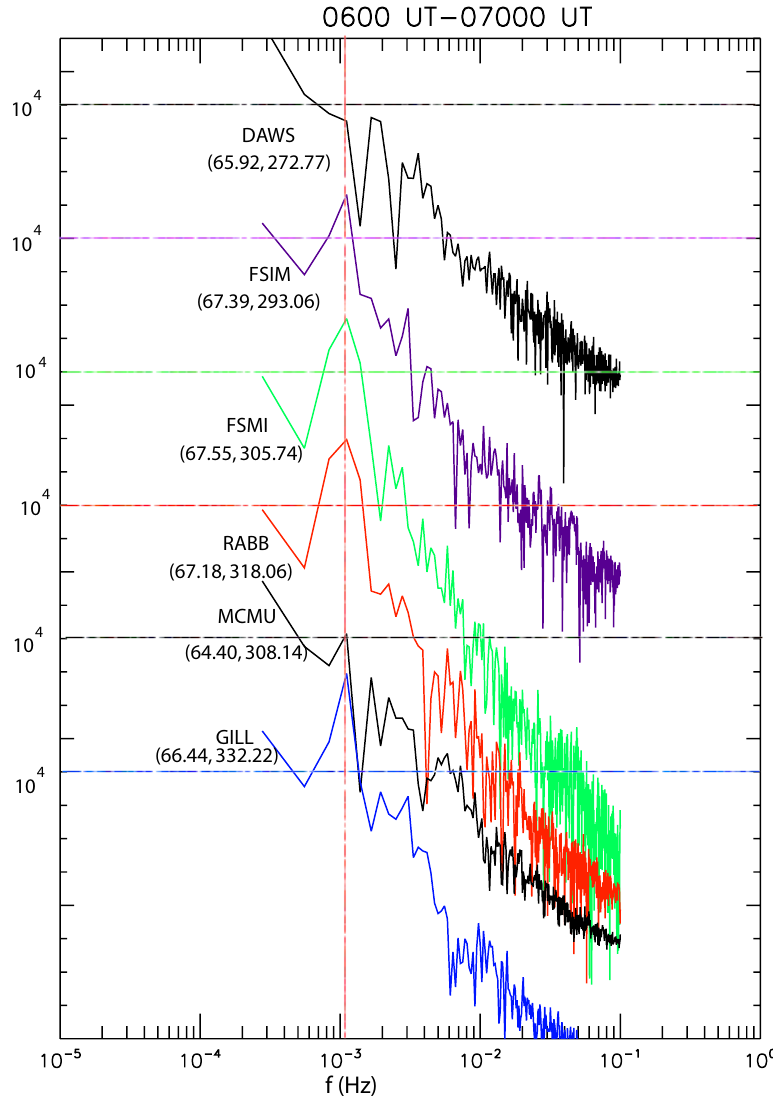
Fig. 7. The power spectra for all the stations along the west-east direction with the same format as Fig. 6.